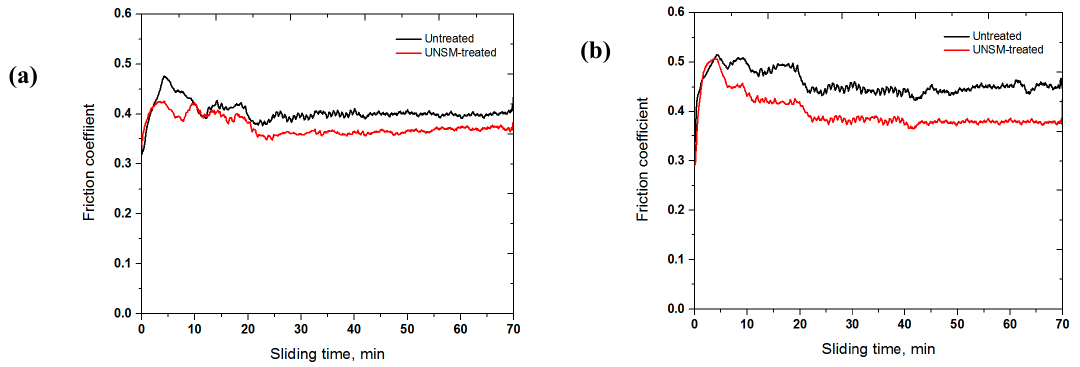
Figure 8. Comparison of friction coefficients of the bulk ( a ) and 3D-printed ( b ) AISI H13 tool steel specimens before and after UNSM treatment.